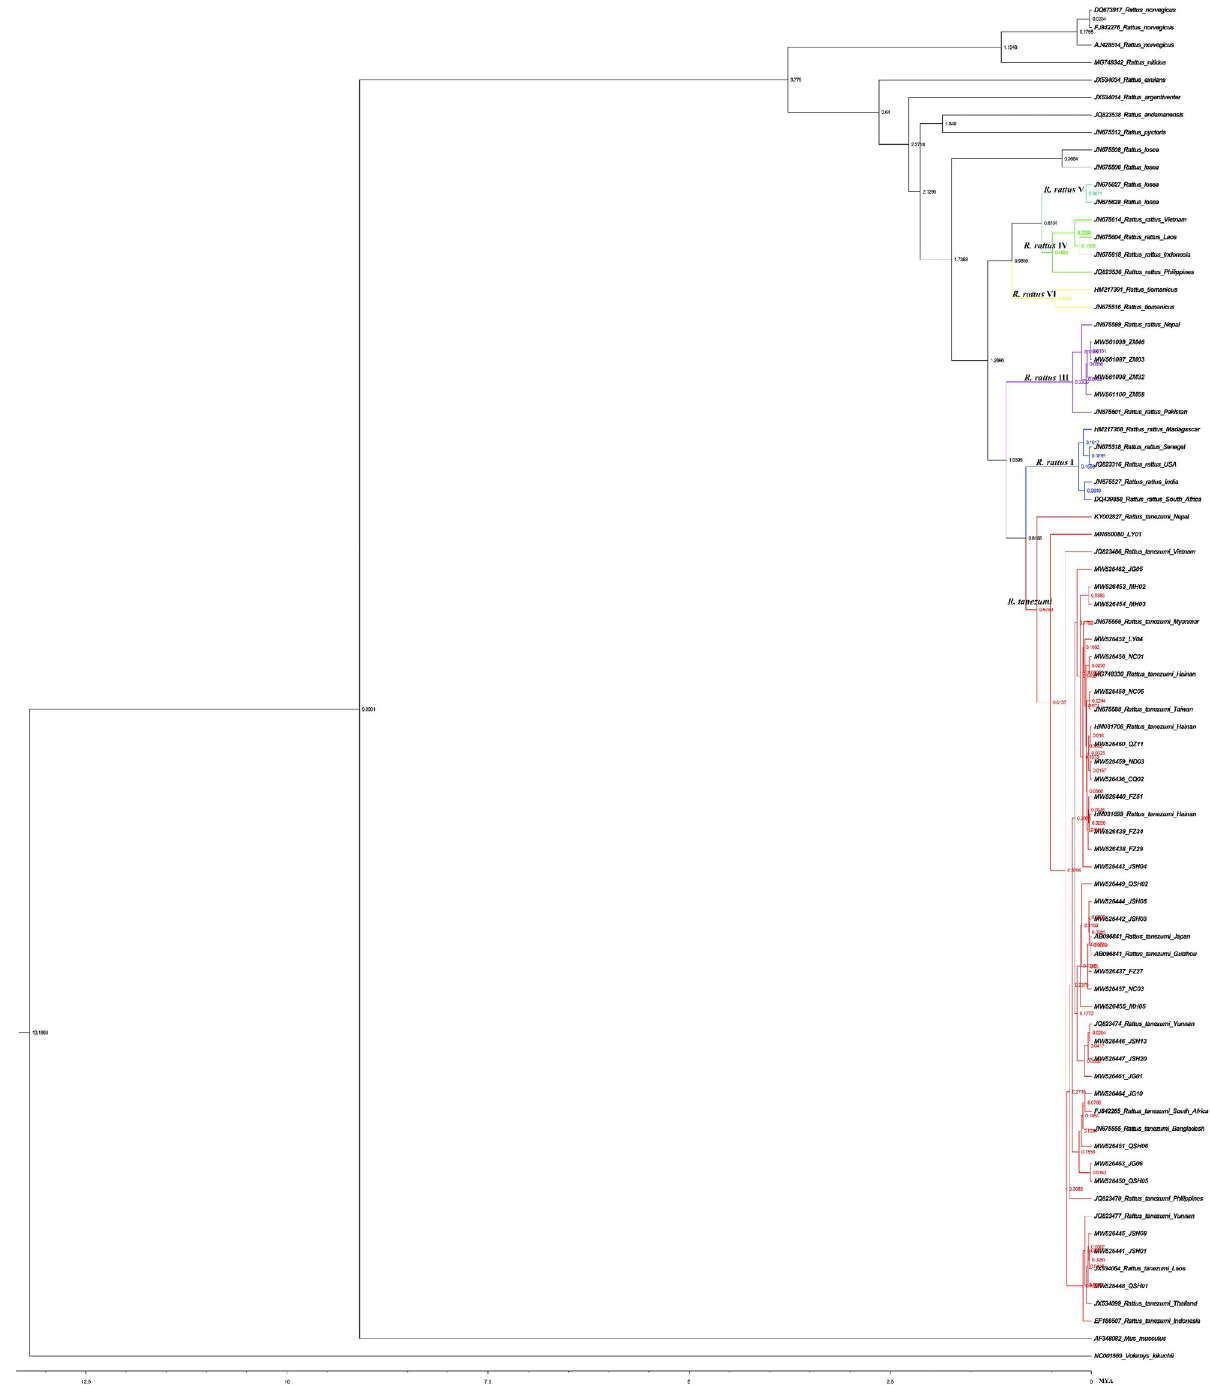
Fig 3. Phylogenetic tree produced with Bayesian inference using MCMC. See S1 Table for a full description of Cytb sequences.